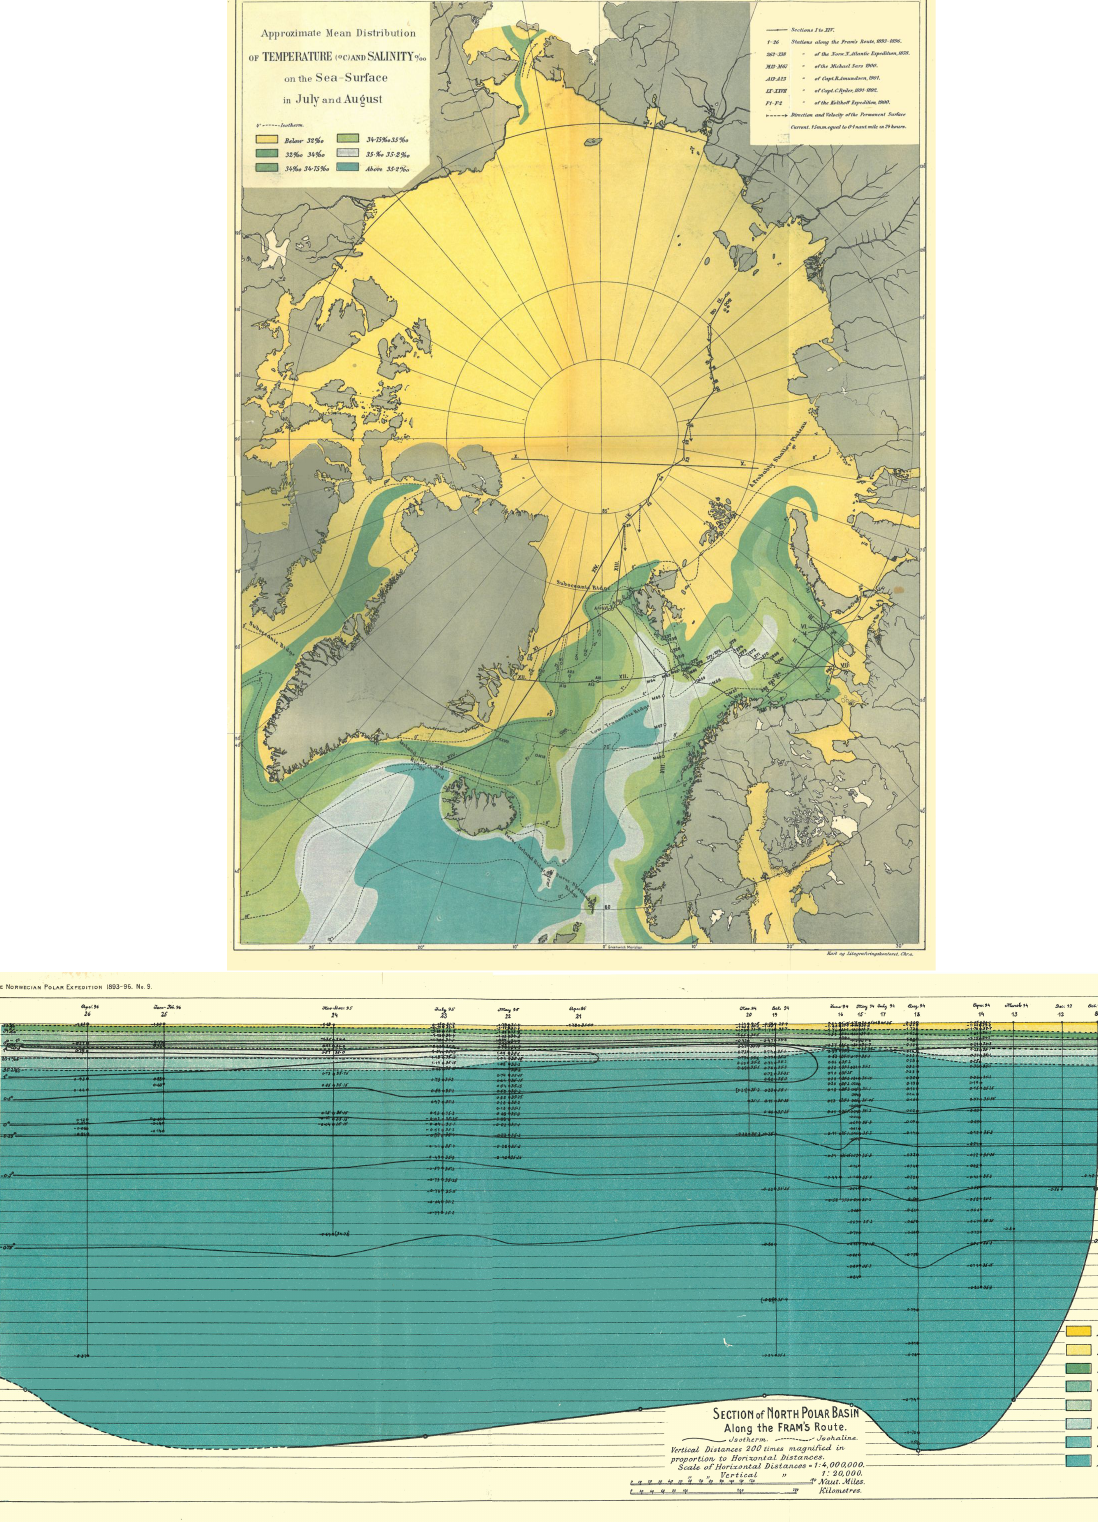
Fig. 2. (a) Map of the Arctic Mediterranean showing the drift of Fram and the surface salinity (colours) and the surface isoterms (dotted lines). From Nansen (1902). (b) Temperature and salinity section based on the hydrographic observations made from Fram during the drift from the Laptev Sea to Fram Strait. From Nansen